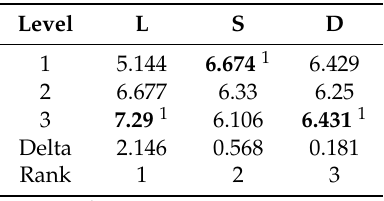
Table 4. Response table for S/N ratios of µ